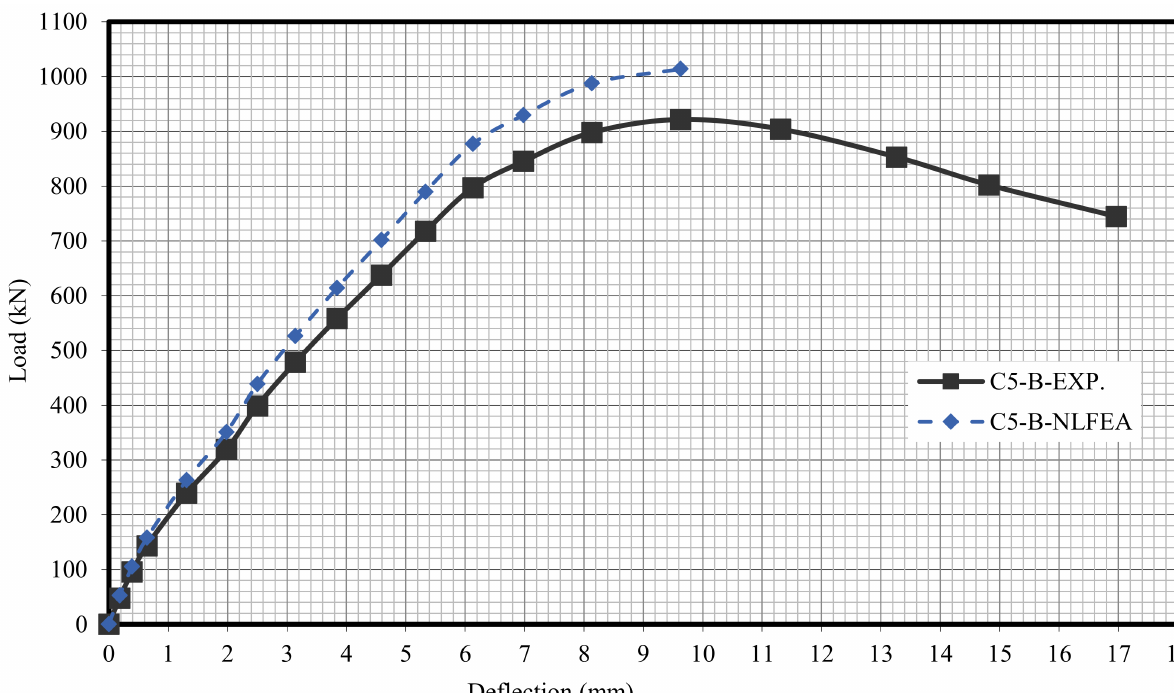
Figure 26. Load deflection of Column